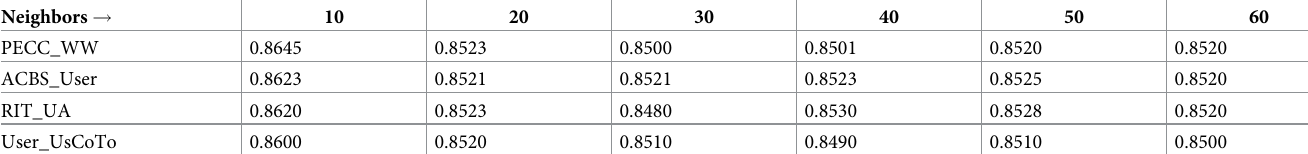
Table 7. RMSE values comparison of the different models against the proposed.